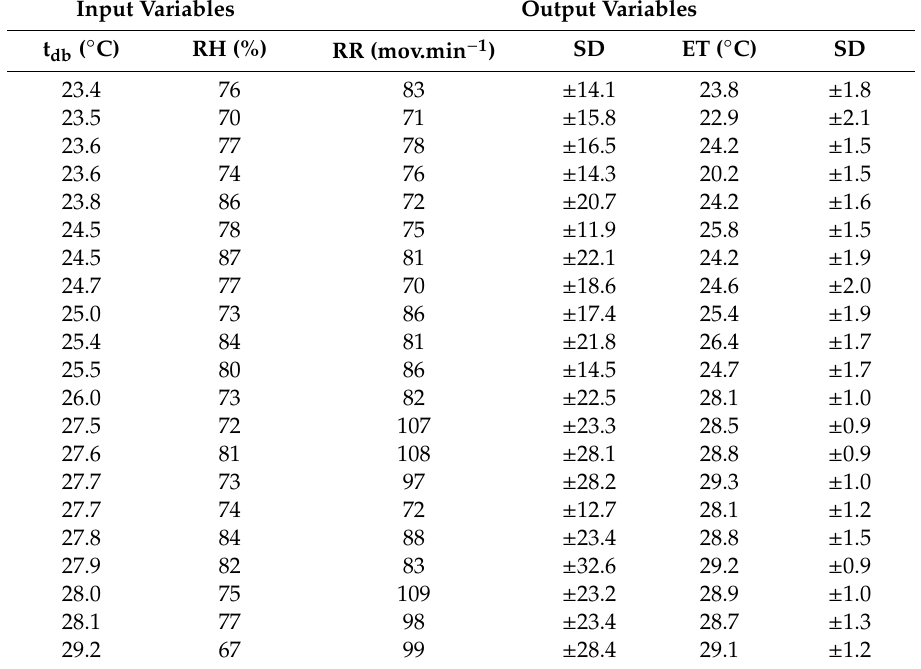
Table 1. Mean experimental values for validation of the decision tree models. Input